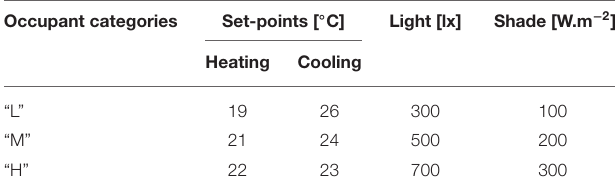
TABLE 2 | Assumptions concerning the three occupant categories (“H,” “M,” “L”) regarding heating and cooling set-points, indoor illuminance threshold for operating electrical lighting, and vertical irradiance threshold [incident on the façade] for operating shades [adapted from Mahdavi et al. (2018) with permission from A. Mahdavi, M. Taheri, and F.